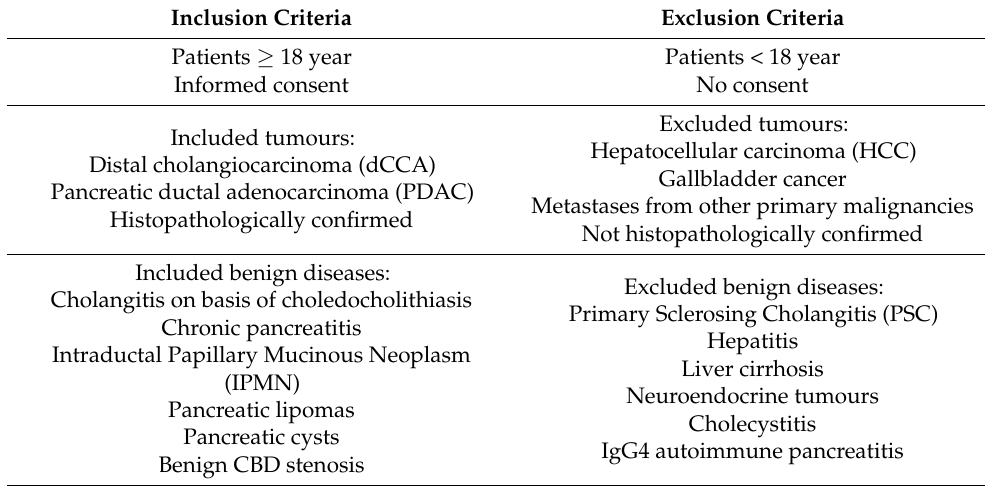
Table 1. Inclusion and exclusion